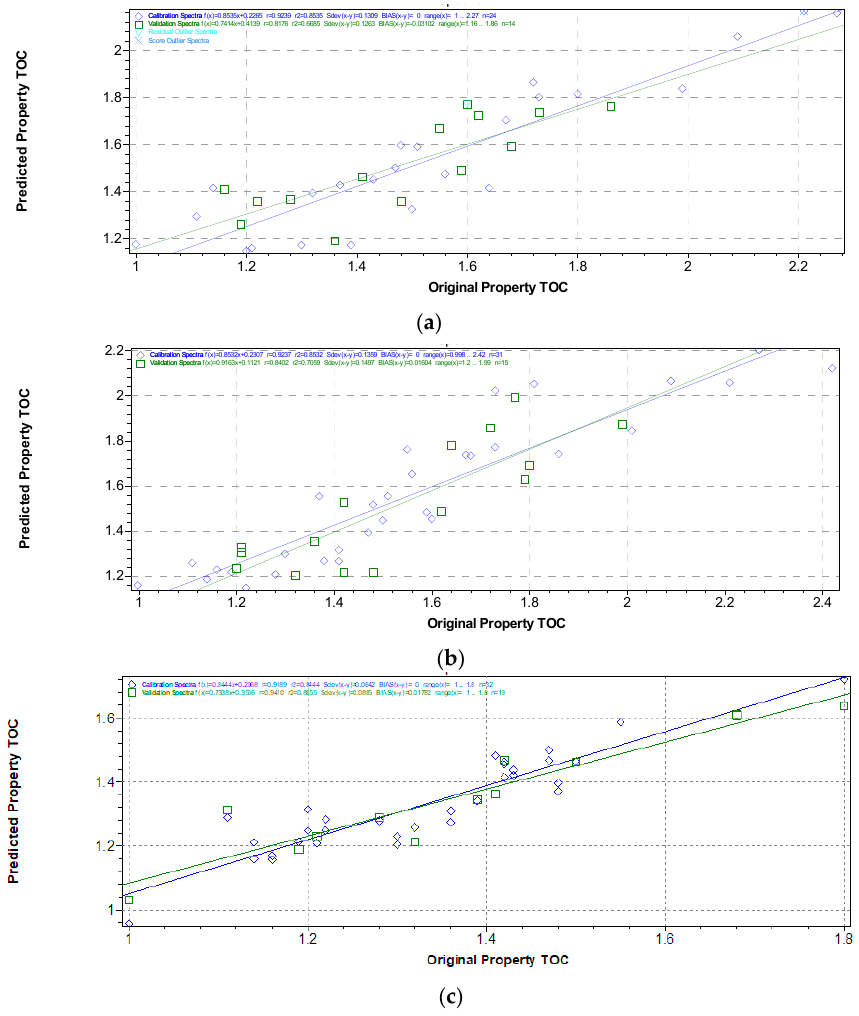
Figure 6. Calibration curves for parameter TOC in soils of original vs. predicted values from the WS dataset ( a ); DS dataset ( b ); GSS dataset ( c ).